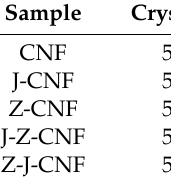
I ) of CNF and modified CNF.